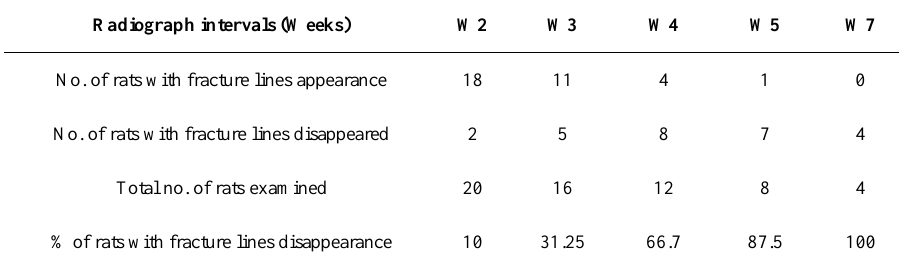
Table 1. Percentage radiographic evidence of fracture line